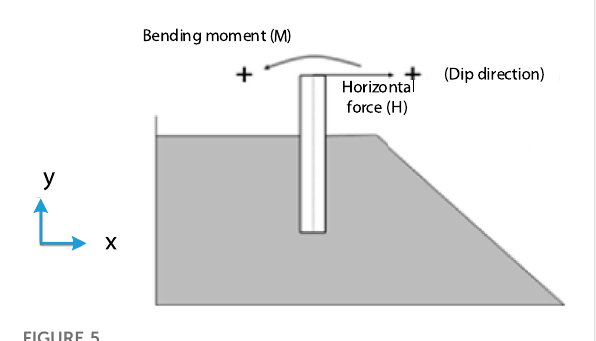
FIGURE 5 Sign de fi nition for the bending moment and horizontal